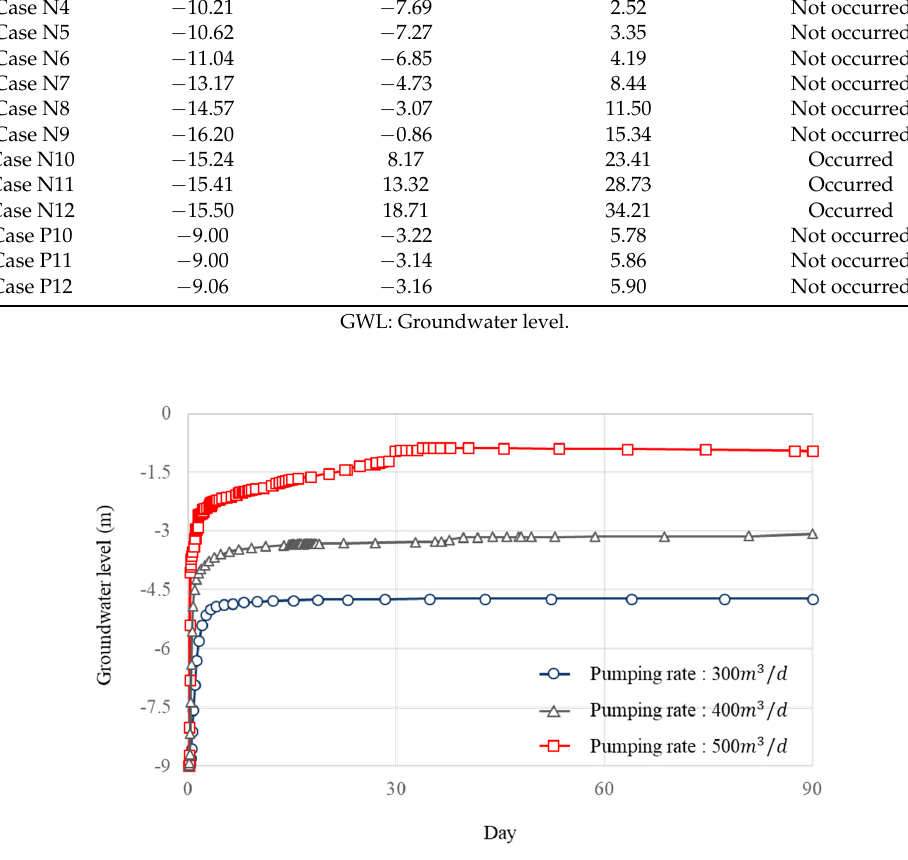
Figure 10. Groundwater level at the injection well in the condition of different pumping rates (hydraulic conductivity: 4 × 10 − 7 m/s).